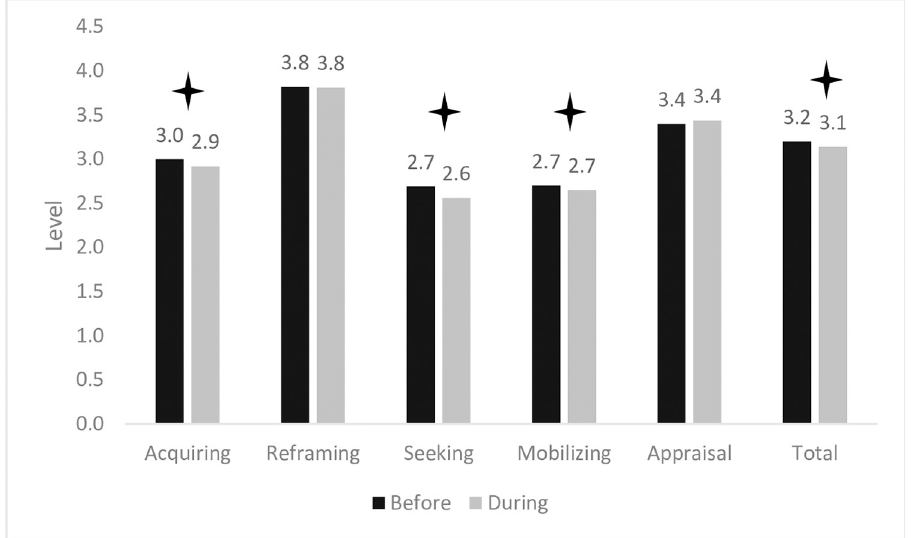
Fig 1. Differences in family pandemic-oriented personal evaluation scale factors pre- and during the COVID-19 pandemic.